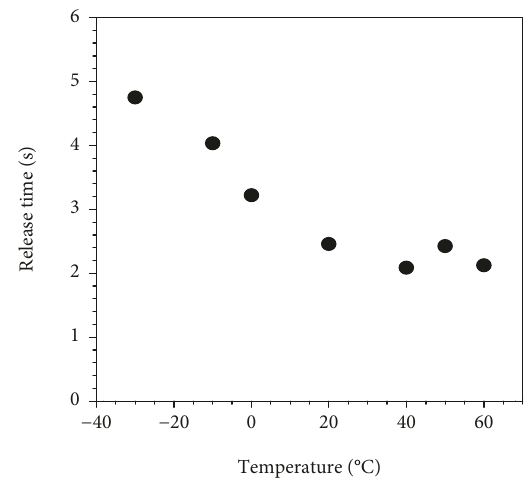
Figure 8: Variation in the release time of a solar panel under quali fi cation temperature ranges.